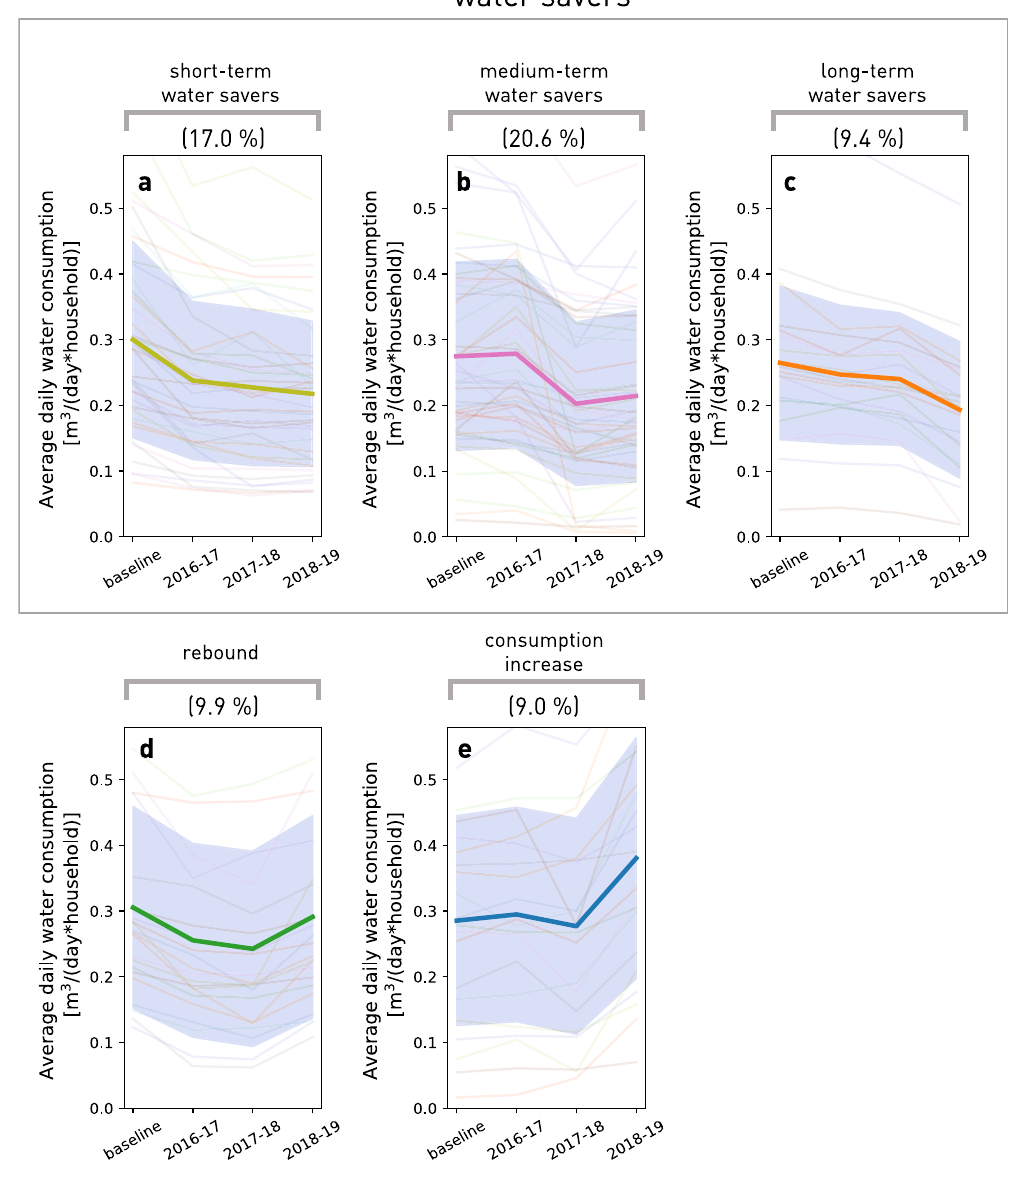
Fig. 3 Long-term water consumption change patterns. Five household segments (clusters) are represented as a selection of the eleven clusters obtained via household segmentation (Supplementary Fig. 9). Households in the treatment group are clustered in different segments based on the correlation distance of their water consumption pattern over the longitudinal study, where a water consumption pattern consists of the four values of average daily household water consumption during the 2015 baseline period and the three observation periods in 2016 – 2019. Each subplot represents a behavior change pattern, described by the labels on top. The percentage on top of each plot reports the percentage of households in the treatment group included in each household segment. Shaded blue areas are de fi ned by the standard deviation around the mean (thick colored line in each